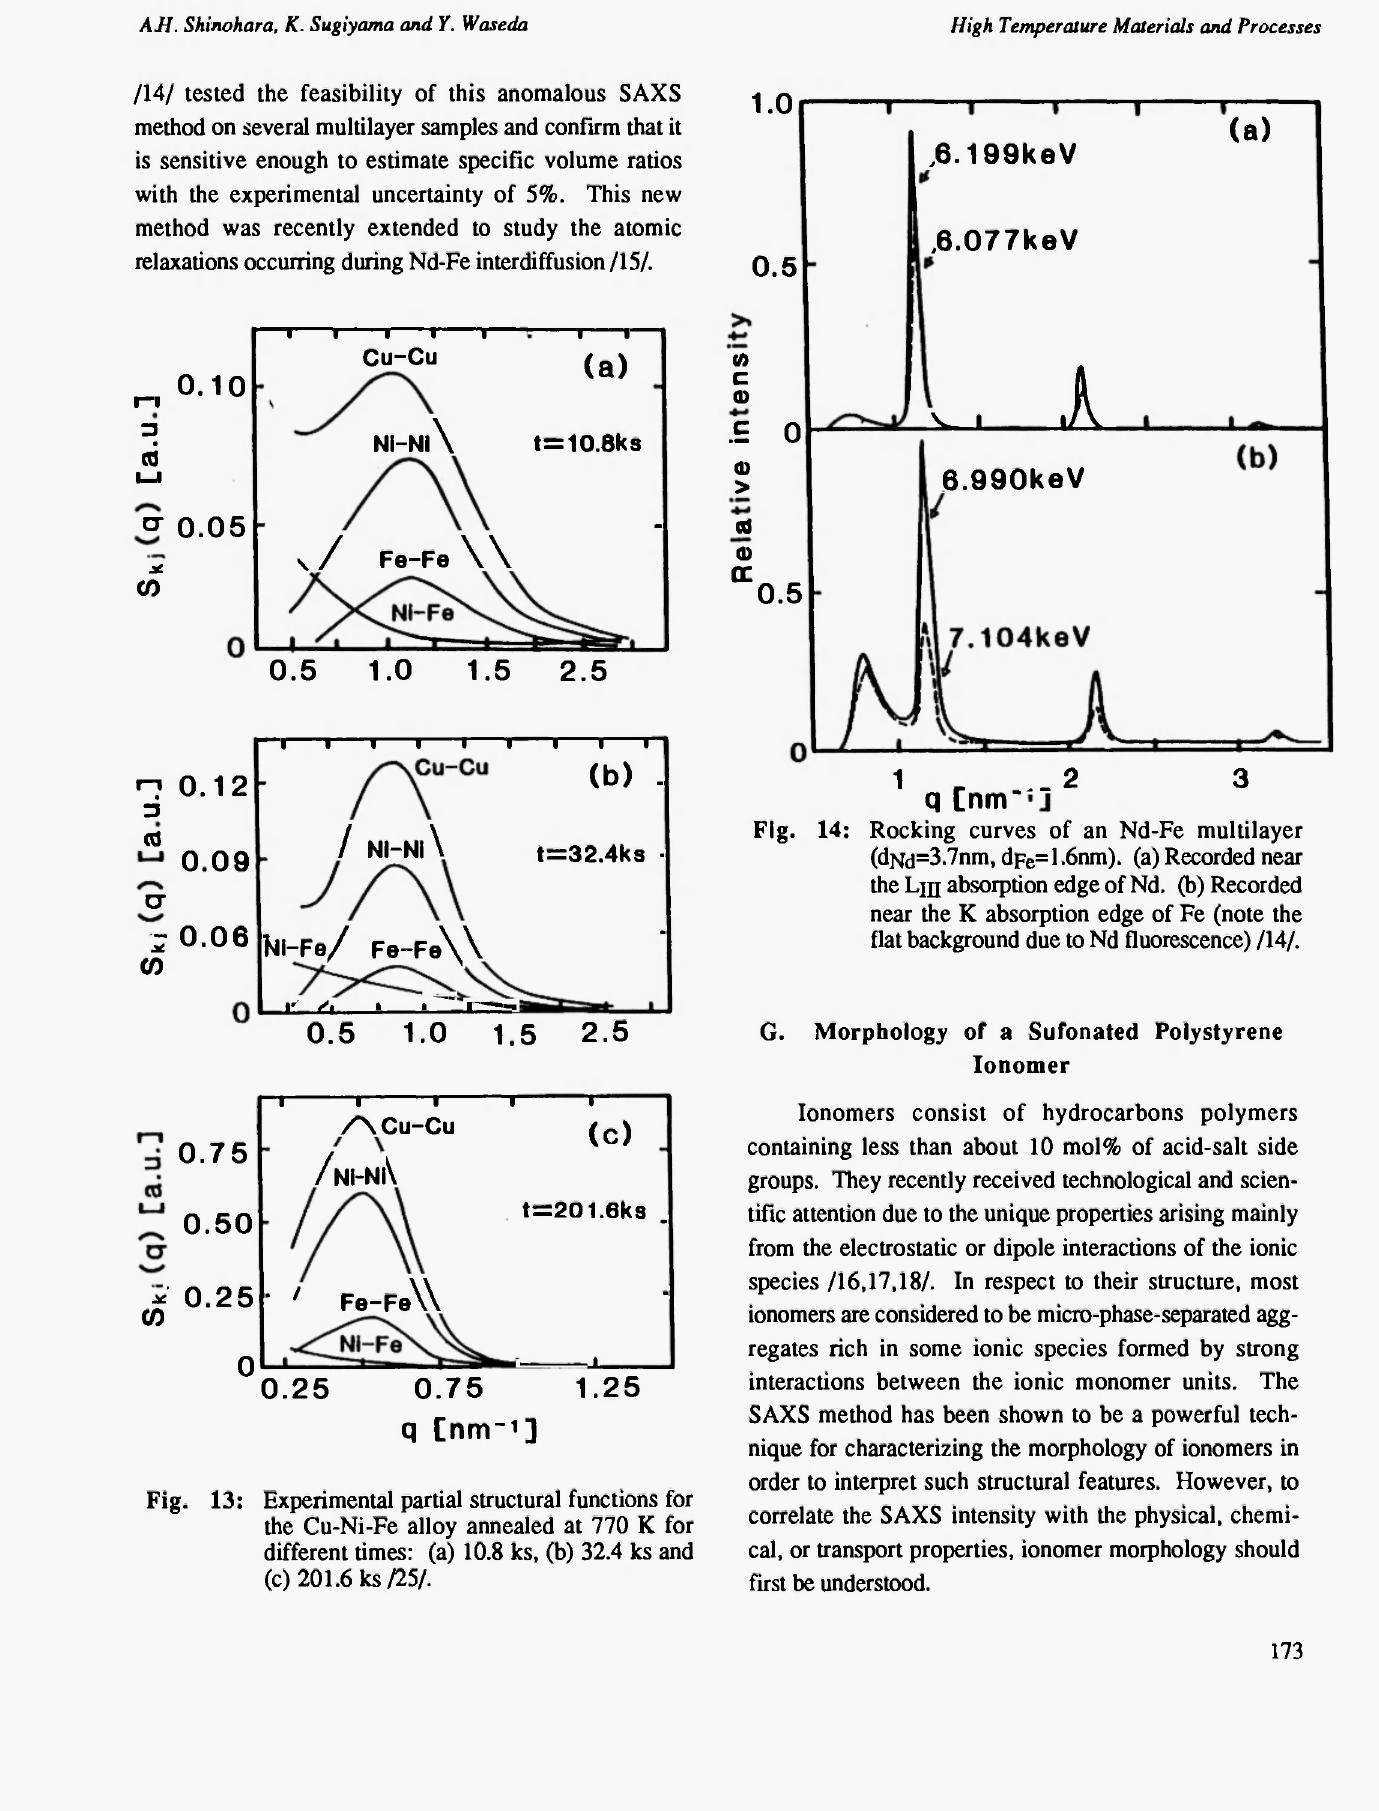
Fig. 13: Experimental partial structural functions for the Cu-Ni-Fe alloy annealed at 770 Κ for different times: (a) 10.8 ks, (b) 32.4 ks and (c) 201.6 ks 1251.